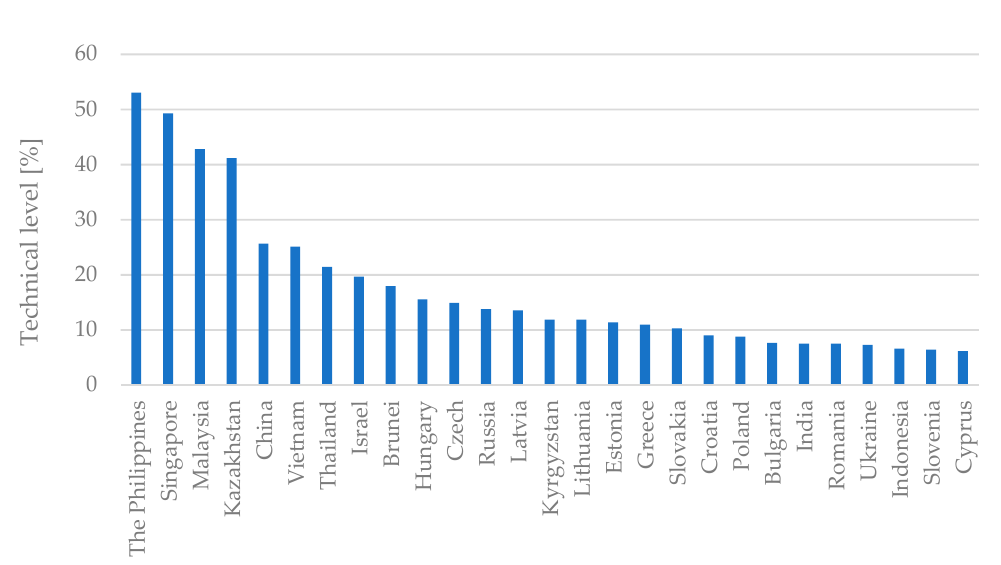
Figure 5. High-tech exports rank of the BRI countries in 2015